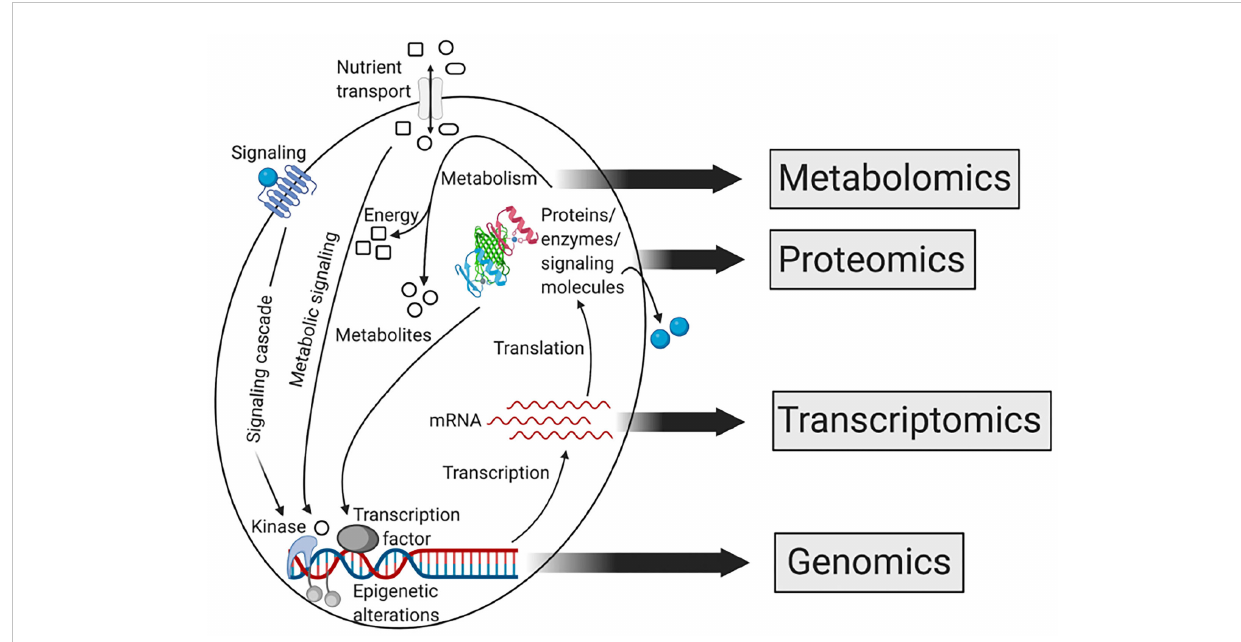
FIGURE 2 Relationship between different omics approaches of systems biology (15). Reprinted (adapted) with permission from the authors. CA: A Cancer Journal for Clinicians published by Wiley Periodicals LLC on behalf of American Cancer Society. (2021). CA Cancer J Clin.